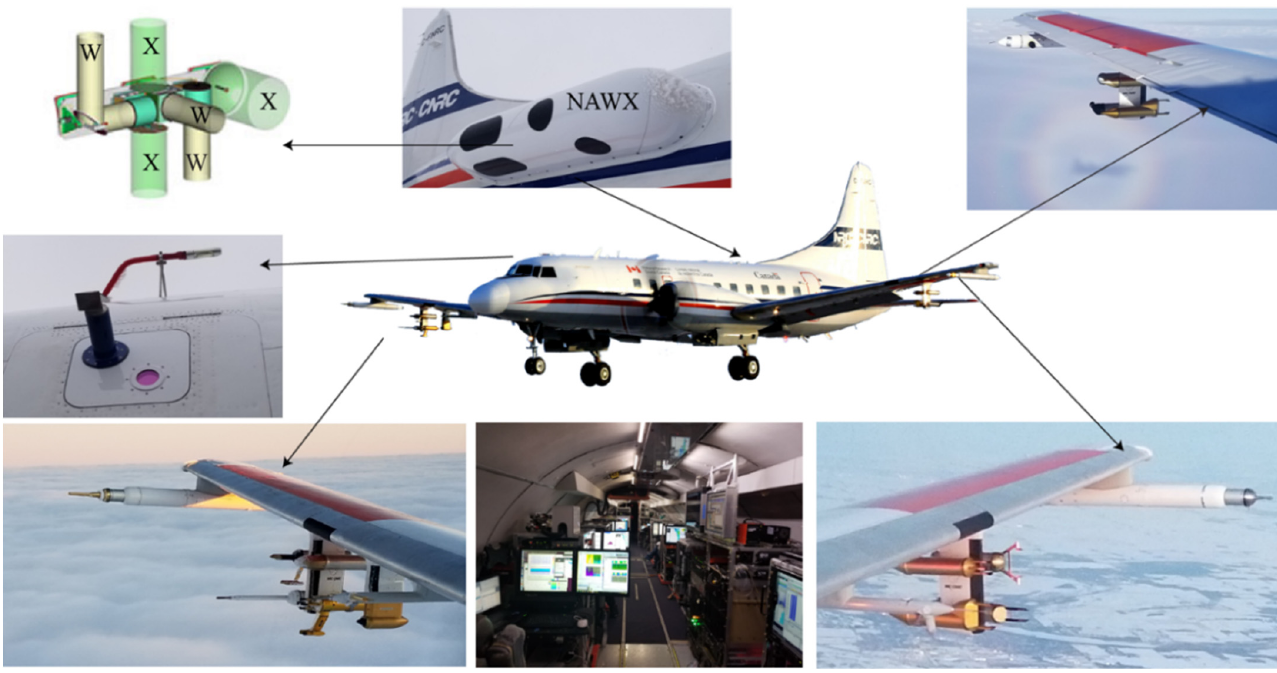
Figure 1. Illustration of the NRC Convair-580 aircraft instrumented for the ICICLE campaign in 2019, reproduced with permission from [24]. Top row: NRC’s radar system (W- and X-band) and its axial pointing options and underwing cloud probes. Middle row: Aerosol isokinetic sampling inlet and bulk water detectors installed on the fuselage. Bottom row: Underwing cloud and atmospheric-state probes. Bottom middle: Cabin configuration with operator stations. Table 1. List of selected parameters that were used for this study (see instrument description